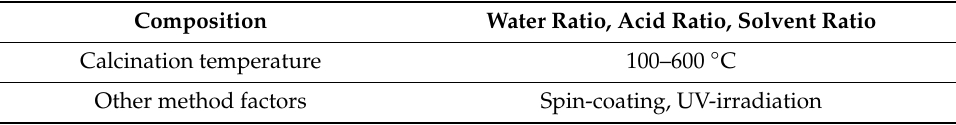
Table 1. E ff ect of the parameters in the sol-gel Table 1. Effect of the parameters in the sol-gel process.